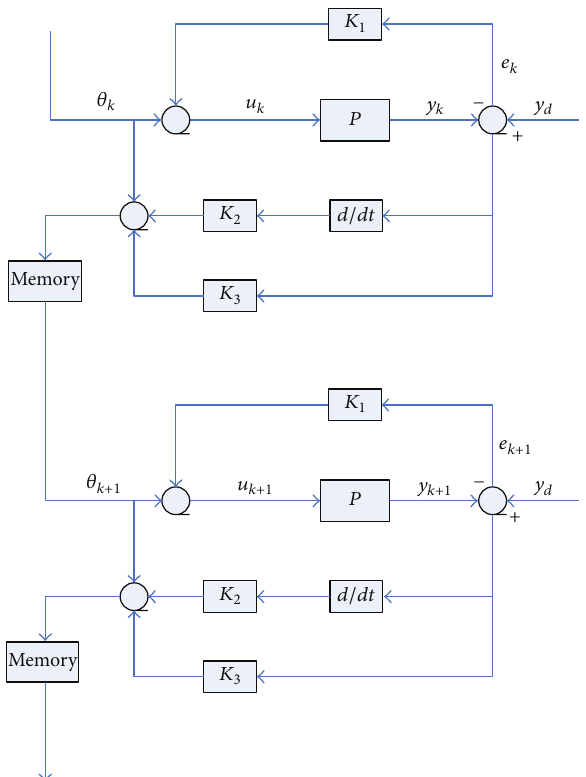
Figure 3: The parametric learning ILC process for the time varying delay